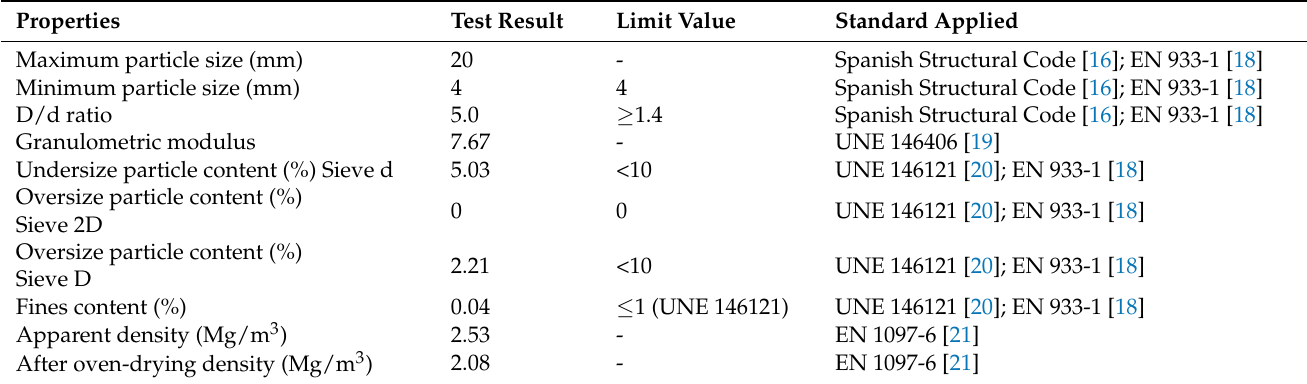
Table 2. Physical and mechanical properties of mixed recycled aggregate .